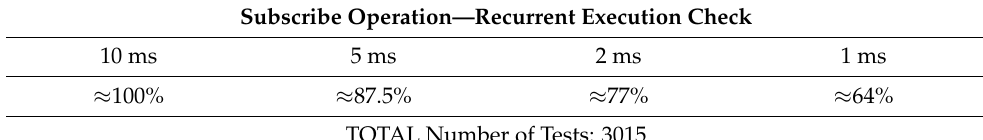
Table 8. OPC UA Diagnose Node—Virtualized Linux OS—Subscribe